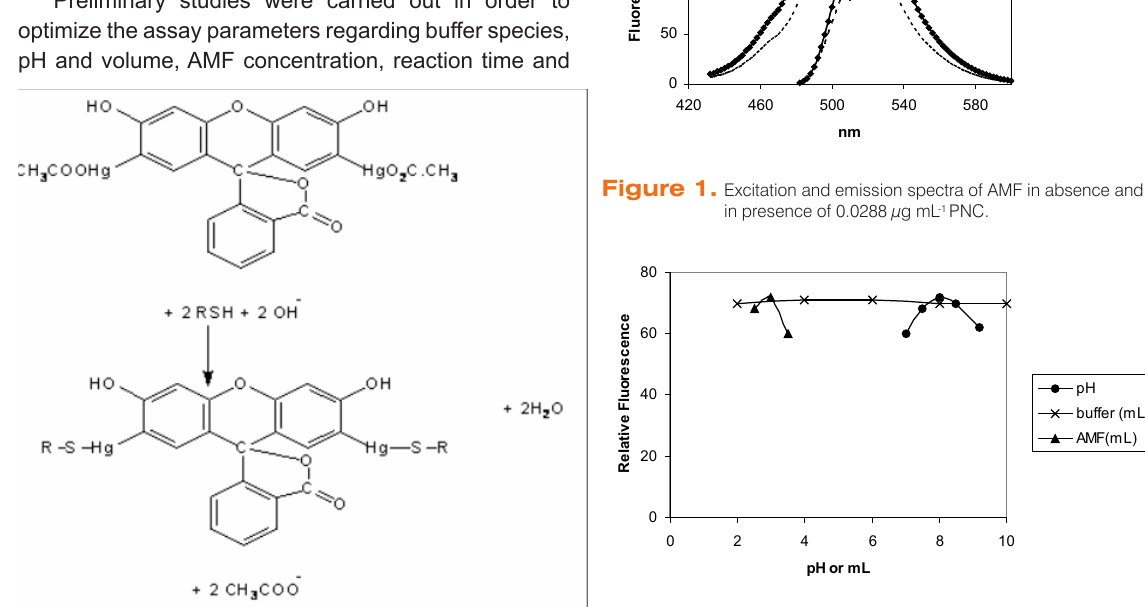
Figure 2. Effect of Kolthoff’s borax- phosphate buffer pH, volume of buffer and AMF (1×10 -4 M) on the reaction